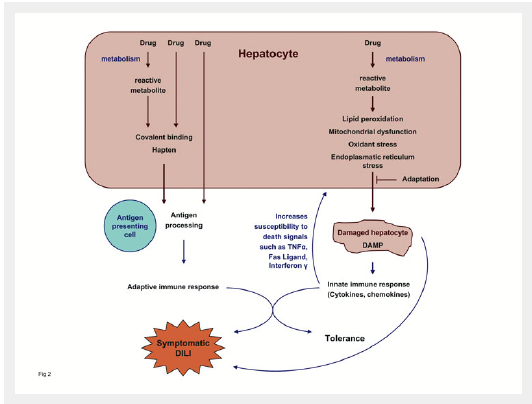
The concept of idiosyncratic DILI. Drug metabolism generates chemically reactive metabolites that interfere with cellular homeostasis. Unless the cell adapts to the metabolic disturbance, the hepatocyte dies and danger signals are released. The ensuing innate immune response increases the susceptibility of hepatocytes to death signals resulting in additional cell damage. Reactive metabolites bound to macromolecules, and possibly also cellular components released from damaged hepatocytes, can also elicit an adaptive immune response that may result in cell damage. The interplay between the innate immune system activated by the danger signals and the adaptive immune system may be an important factor in determining whether tolerance or symptomatic DILI ensues. Depending on the drug involved and the host response, one step or the other step may be more relevant for the